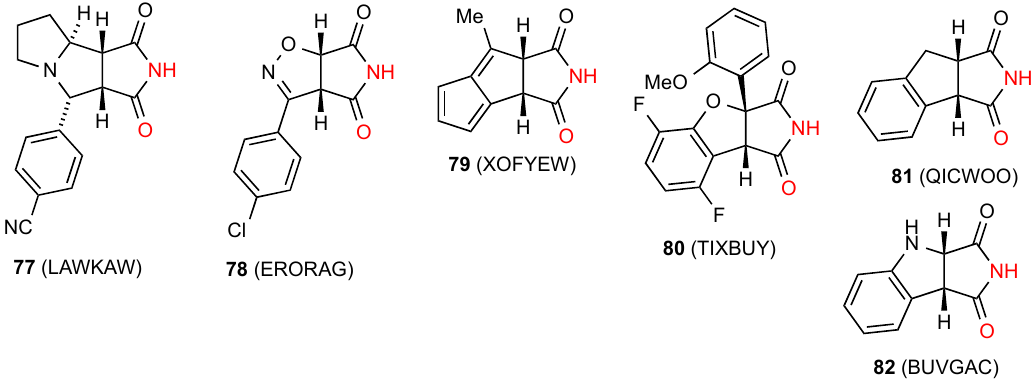
Figure 28. Five-membered ring-fused succinimides showing patterns A and B.